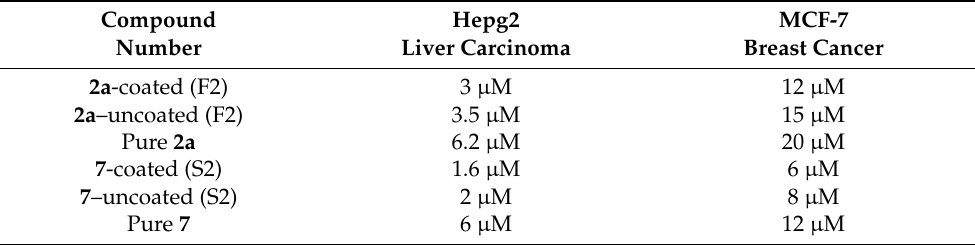
Table 9. In vitro cytotoxic activities of 2a - and 7 -loaded niosomes (F2 and S2) either being coated with TPGS versus the uncoated ones (IC50 values ( µ M)) against HepG2 and MCF-7 cell